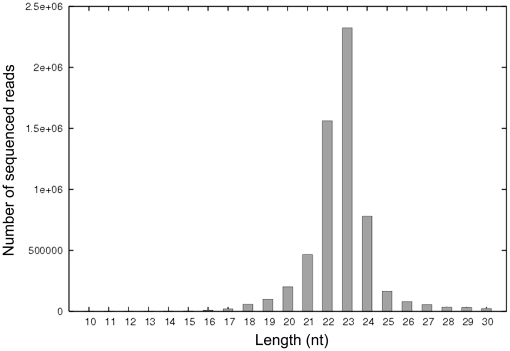
Size distribution and abundance of sequenced small RNAs from SGIV-infected GP cells.The majority of the reads were 23 nt in length.